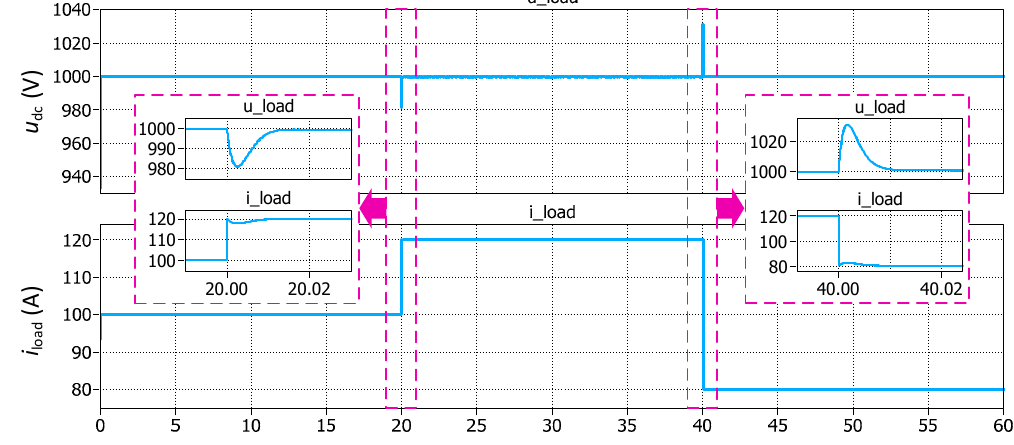
Figure 9. The DC bus voltage and load current in all-electric mode.